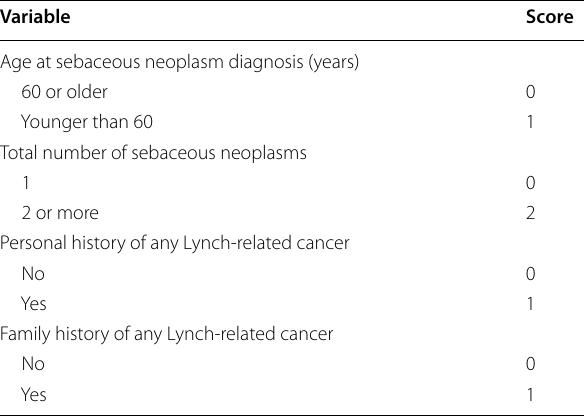
Table 2 Mayo Muir–Torre syndrome risk